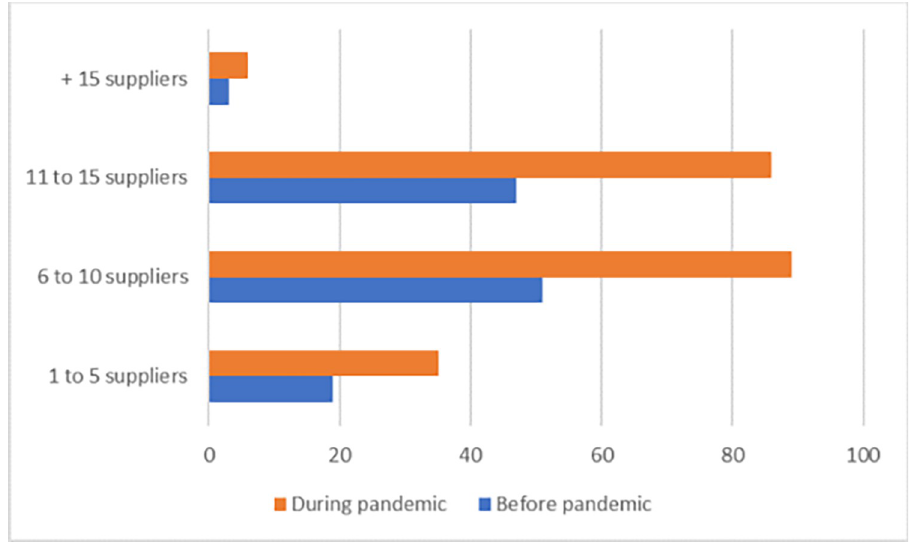
Fig 3. Number of suppliers. Source: By the authors.